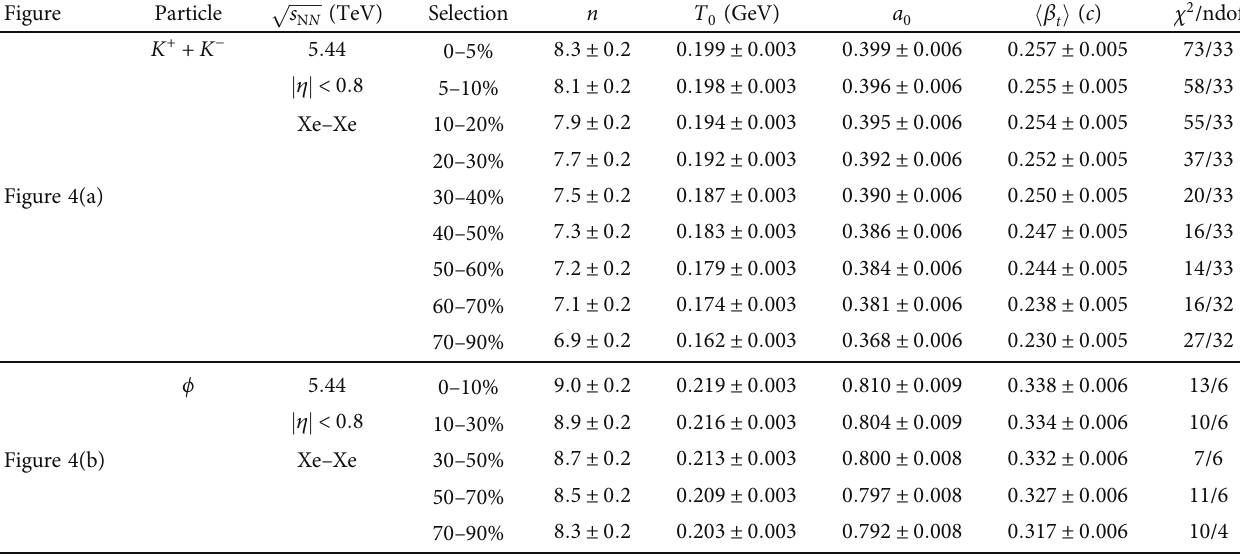
a h β i , χ 2 , and ndo f corresponding to the solid curves in Figure 4. 0 , 0 , t